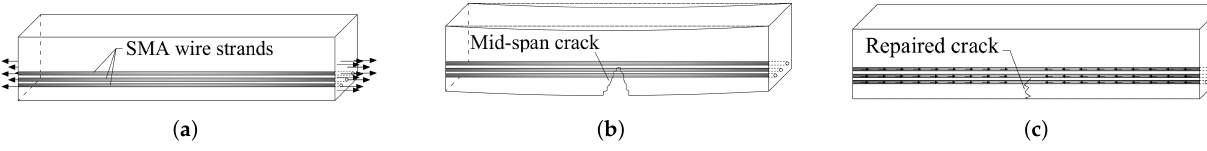
Figure 11. Schematic of intelligent RC specimen: ( a ) RC beam downside is under tension; ( b ) Micro-cracks appear in mid-span; ( c ) Activated SMA wire strands upon heating reduce the micro-cracks